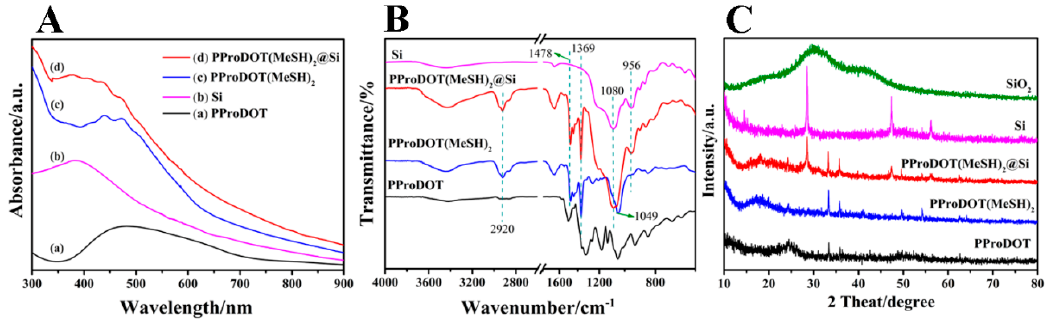
Figure 2. ( A ) UV–Vis spectra, ( B ) Fourier transform infrared (FT-IR) spectra, ( C ) X-ray diffraction (XRD) patterns of porous silicon spheres (Si), PProDOT, PProDOT(MeSH) 2 and PProDOT(MeSH) 2 @Si